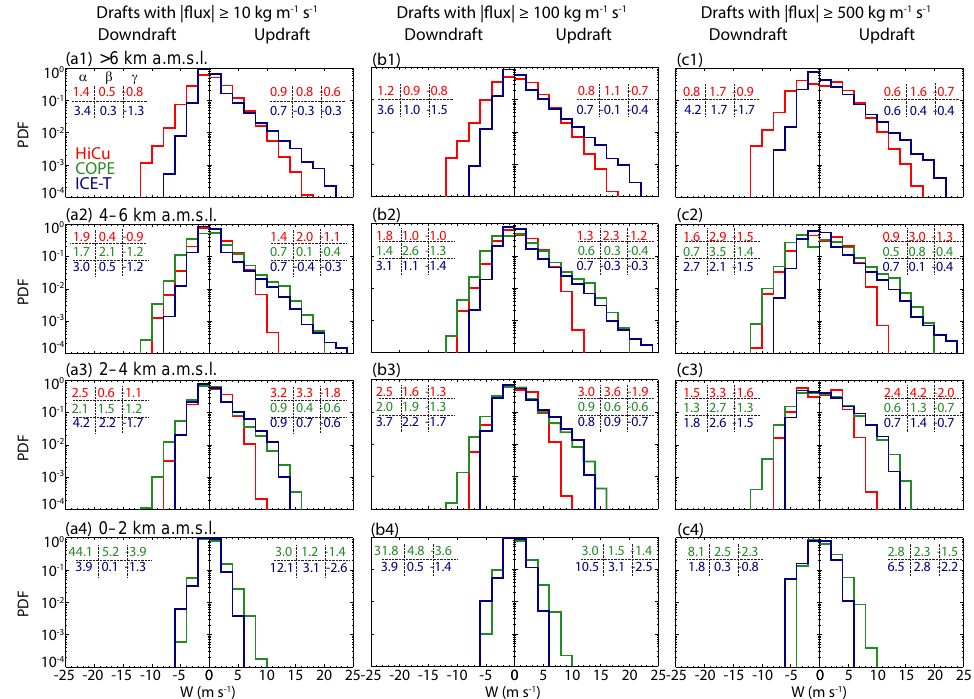
Figure 8. PDFs of the 25Hz vertical velocity for the updrafts and downdrafts with air mass flux ≥ (a) 10kgm − 1 s − 1 , (b) 100kgm − 1 s − 1 , and (c) 500kgm − 1 s − 1 in magnitude, sampled at 0–2, 2–4, and 4–6km and higher than 6km. The numbers shown in each panel are the coefficients of the fitted exponential function (Eq.